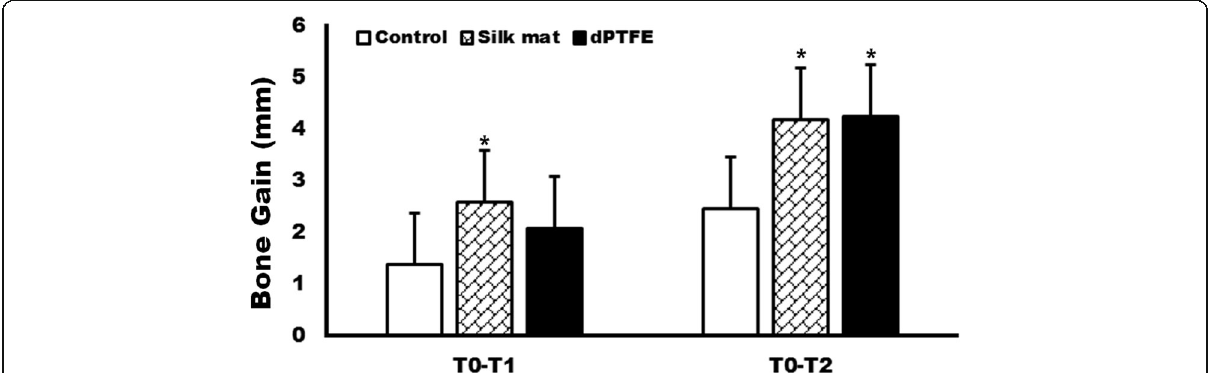
Fig. 3 The amount of bone gain (BG) at 3 months (T1) and 6 months after tooth extraction (T2). In a post hoc test, BG in the silk mat group showed a significantly higher gain compared with the control group (nonregenerative/nongraft procedure) at T1. Both membrane groups showed significantly higher BG than the control group (nonregenerative/nongraft procedure) at T2 (* P <